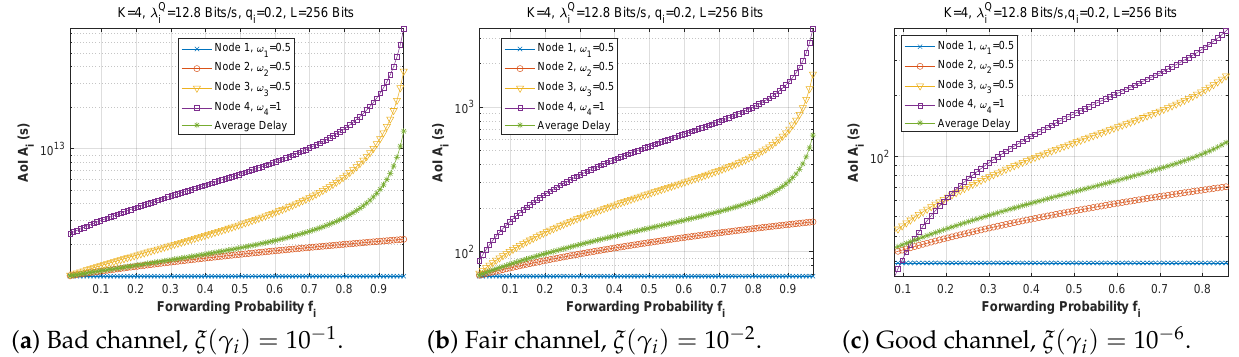
Figure 19. Setting 1: The AoI experienced at each mobile device when varying the forwarding probability with the bit error rate ξ ( γ i )